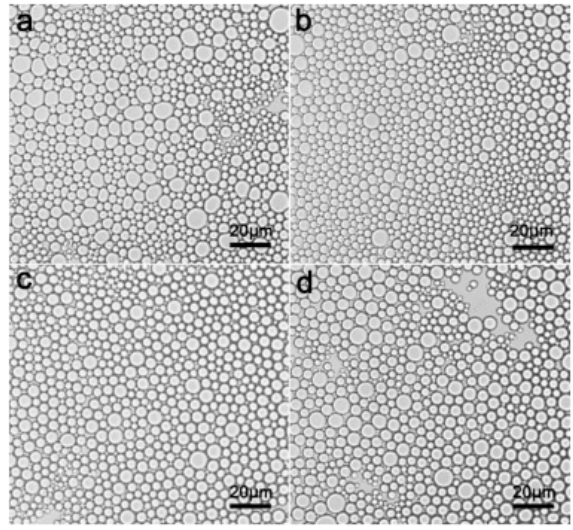
Figure 8. Micrograph images of emulsions stabilized by ( a ) IDF(water-insoluble dietary-fibers )-0, ( b ) IDF-10, ( c ) IDF-30, ( d ) IDF-50 dispersions respectively, the solid content of the IDF dispersions was 0.3 wt%, and the volume ratio of oil to water was 3:7 [117].